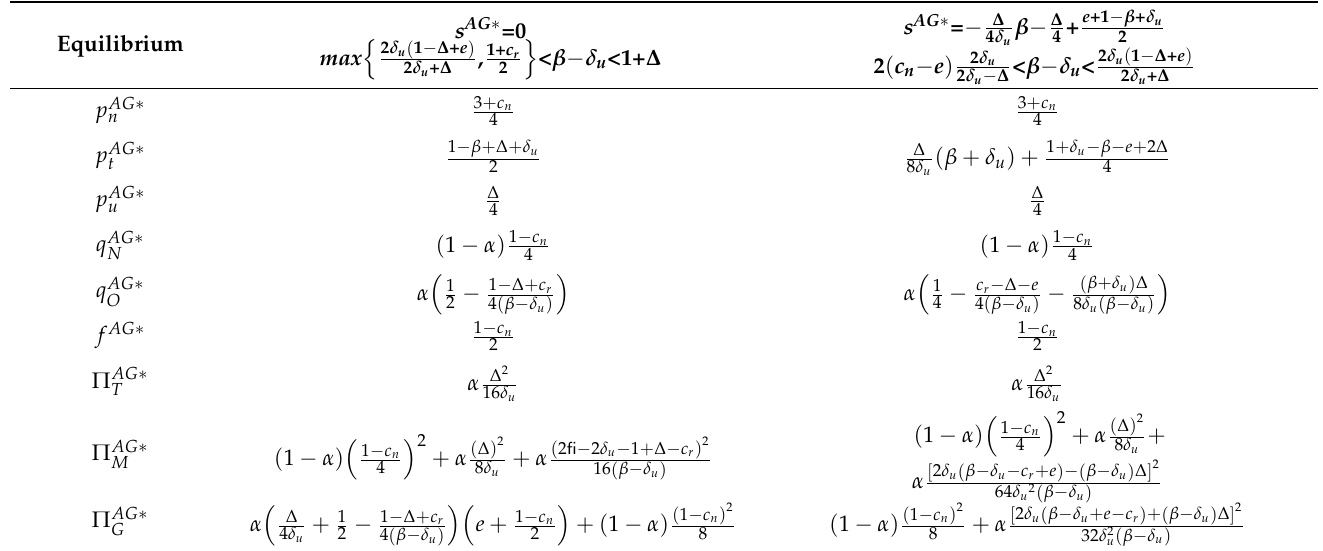
Table 8. Equilibrium optimal solution and optimal profit under Model